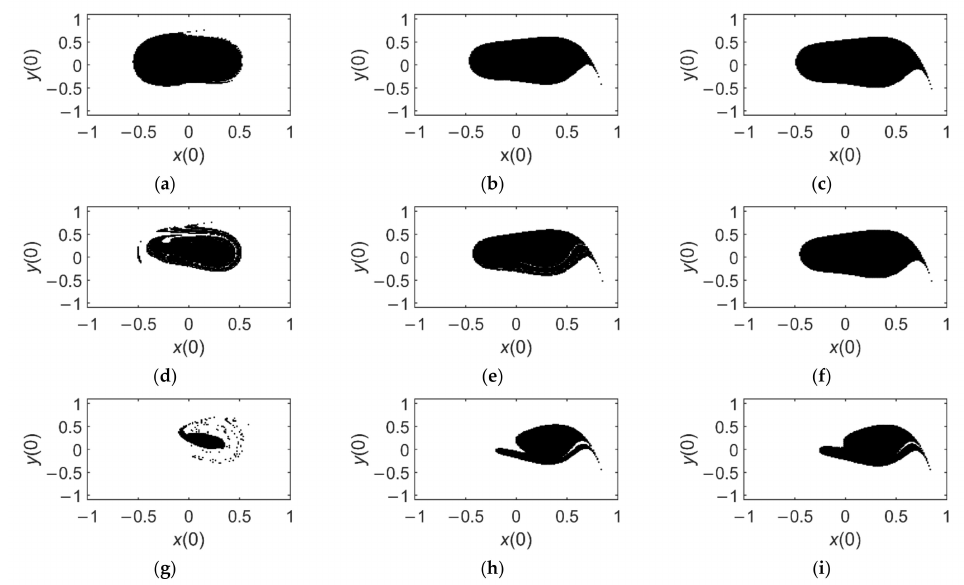
Figure 15. Safe basins of velocity-feedback-controlled system (40) under different V AC and τ : ( a ) V AC = 0.46 V, τ = 0; ( b ) V AC = 0.46 V, τ = 1.6; ( c ) V AC = 0.46 V, τ = 2; ( d ) V AC = 0.52 V, τ = 0; ( e ) V AC = 0.52 V, τ = 1.6; ( f ) V AC = 0.52 V, τ = 2; ( g ) V AC = 0.81 V, τ = 0; ( h ) V AC = 0.81 V, τ = 1.6; ( i ) V AC = 0.81V, τ =